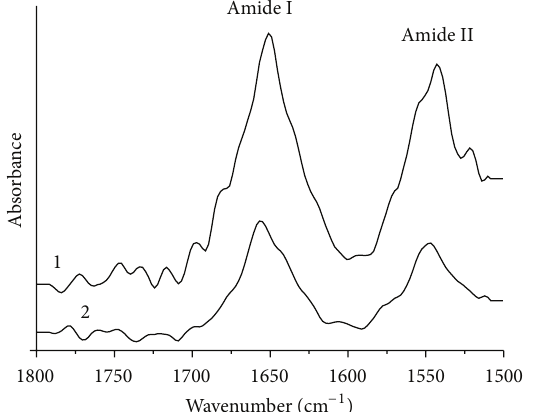
Figure 4: FTIR difference spectra of BSA in Tris-HCl buffer = 1.0 × 10 −4 molL −1 ); (2) bonded BSA solution. (1) free BSA ( 𝐶 BSA = 1.0 × 10 −4 molL −1 , 𝐶 = 2.0 × 10 −4 molL −1 ). pH = 7.4. ( 𝐶 BSA TRES